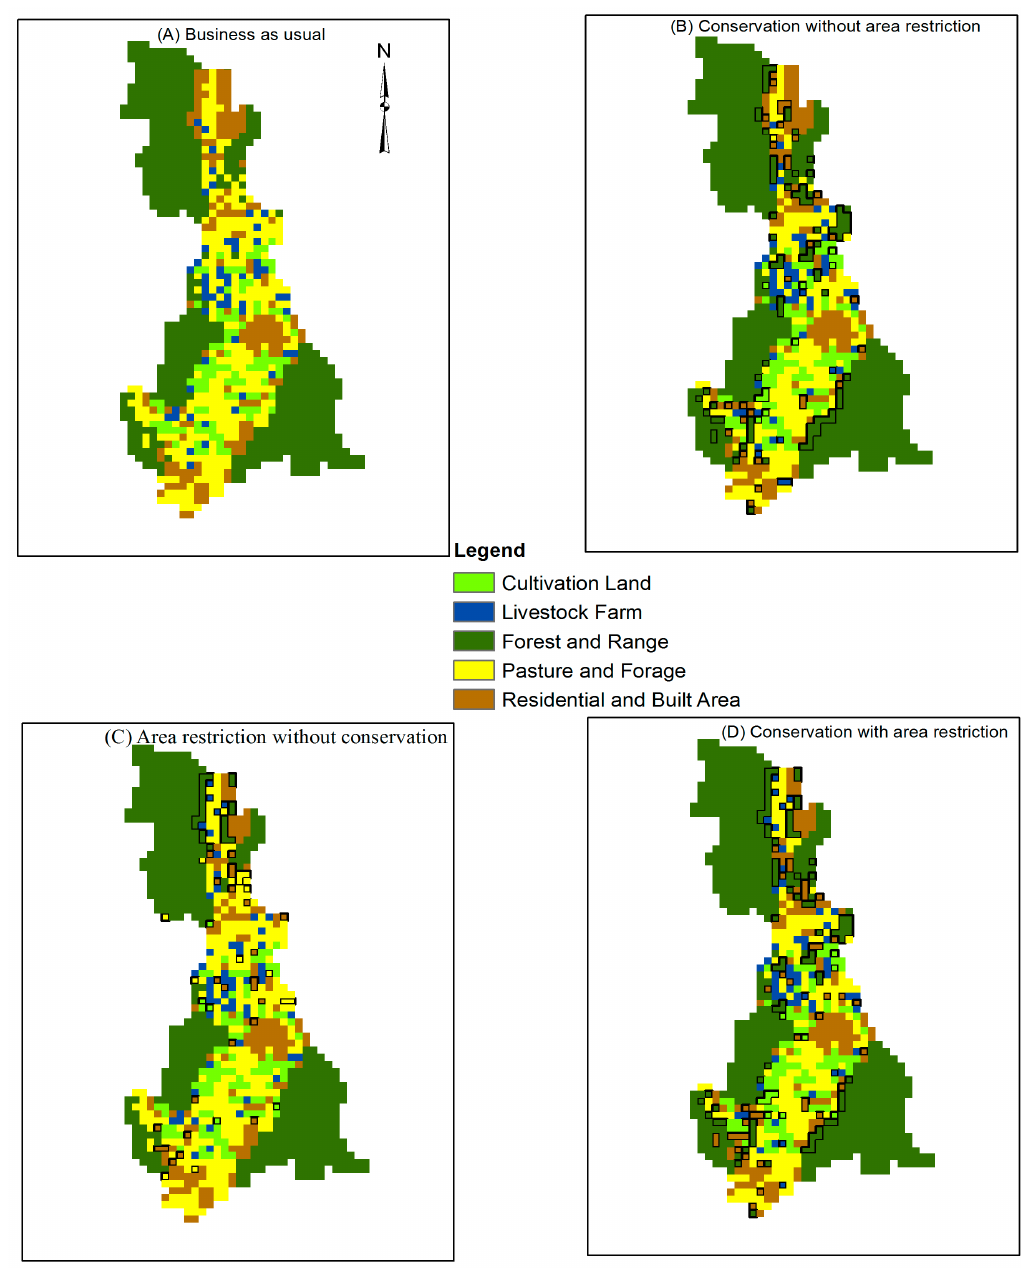
Figure 3. Projected land-use changes at 2050 under four varying scenarios. ( a ) Business as Usual (BAU) scenario, with no new forest conservation policies; ( b ) Conservation without Area Restriction (C) policy scenario, where conversion of forest land is halted from 2030 onwards; ( c ) Area Restriction without Conservation (AR) policy scenario, where forest development in that part of the watershed inside the Regional District of Columbia Shuswap is halted throughout; ( d ) Conservation and Area Restriction (CAR) policy scenario where both policies are in place. Grids with difference in land use from BAU are indicated by surrounding borders for other scenarios.